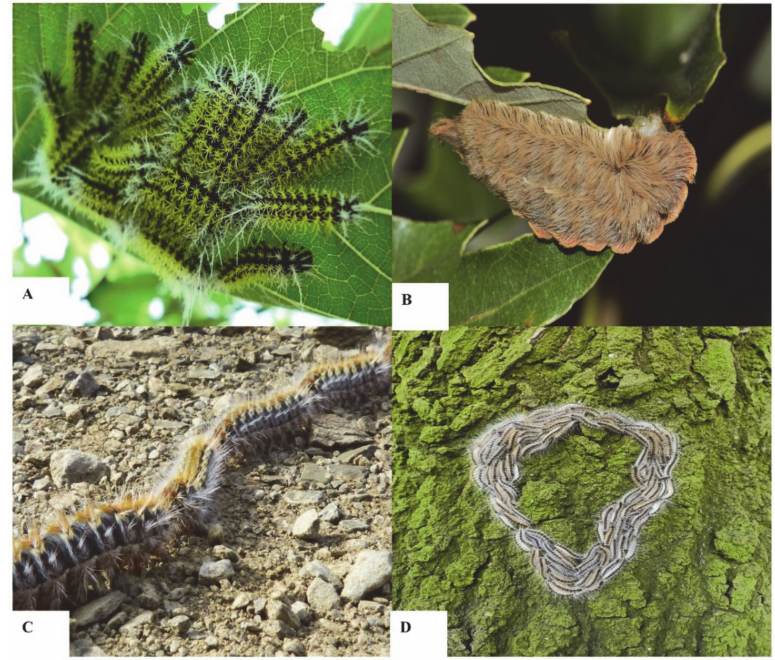
Figure1. Representationofdifferentvenomouscaterpillarspecies. ( A ) Leucanellamemusae , ( B ) Megalopyge opercularis , ( C ) pine processionary caterpillar ( Thaumetopoea pityocampa ), ( D ) oak processionary caterpillar ( Thaumetopoea processionea ).